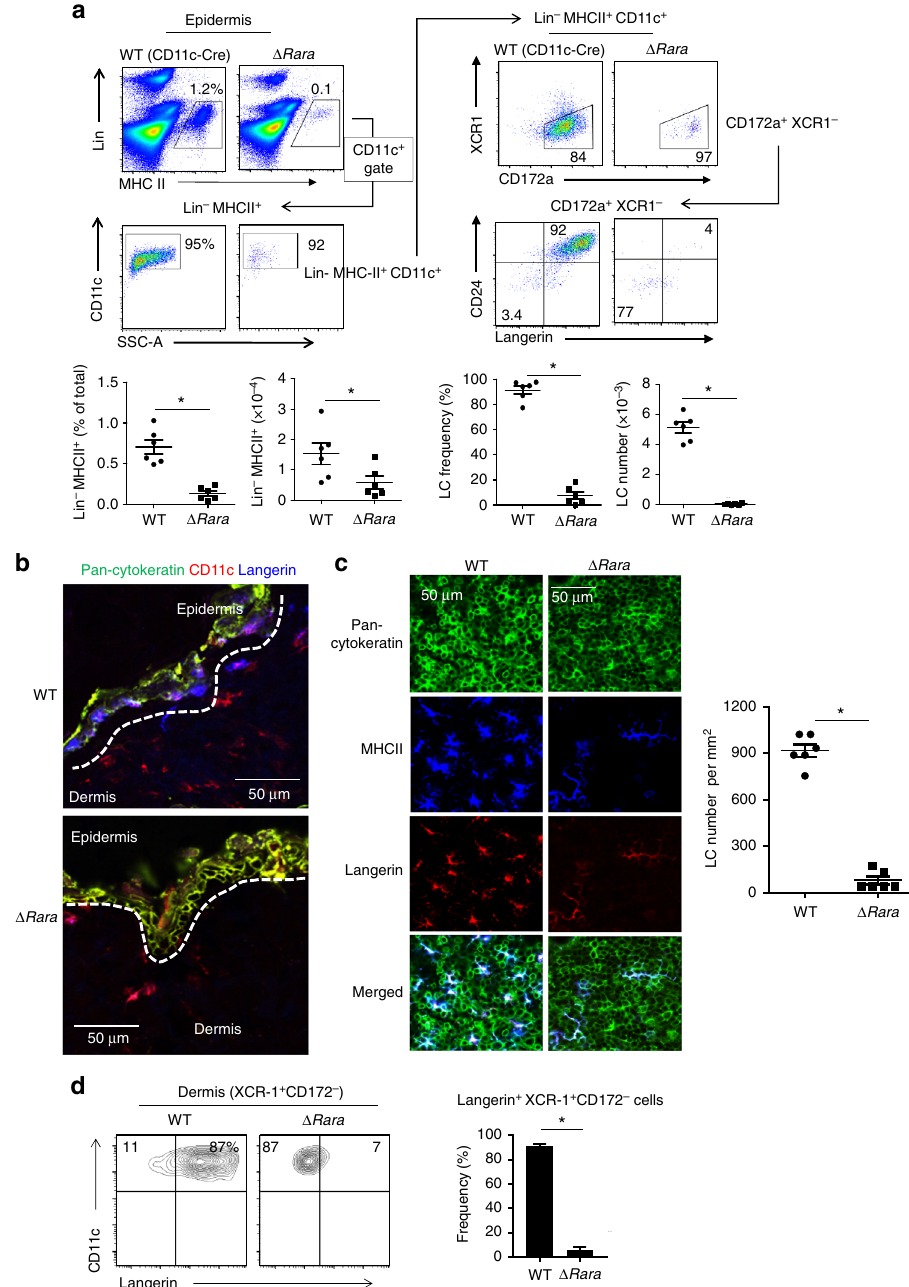
Fig. 1 LC development requires RAR α . a Frequency of langerin + cells in the epidermis of WT and Δ Rara CD11c mice. b Immuno fl uorescence detection of langerin + DCs in cross-sections of the ear skin of WT and Δ Rara CD11c mice. The white dashed lines indicate the border between the epidermis and dermis. c Immuno fl uorescence detection of langerin + DCs in epidermal sheets of the ear skin of WT and Δ Rara CD11c mice. Representative and combined data are shown. d Langerin expression by dermal DCs from WT vs. Δ Rara CD11c mice. As WT control mice, C57BL/6 or CD11C-Cre-GFP mice were used. Representative and combined data ( n = 4 – 8) from at least 3 experiments are shown. *Signi fi cant differences from control mice by Mann-Whitney U test ( p < 0.05, unpaired, 2-sided). Error bars are de fi ned as